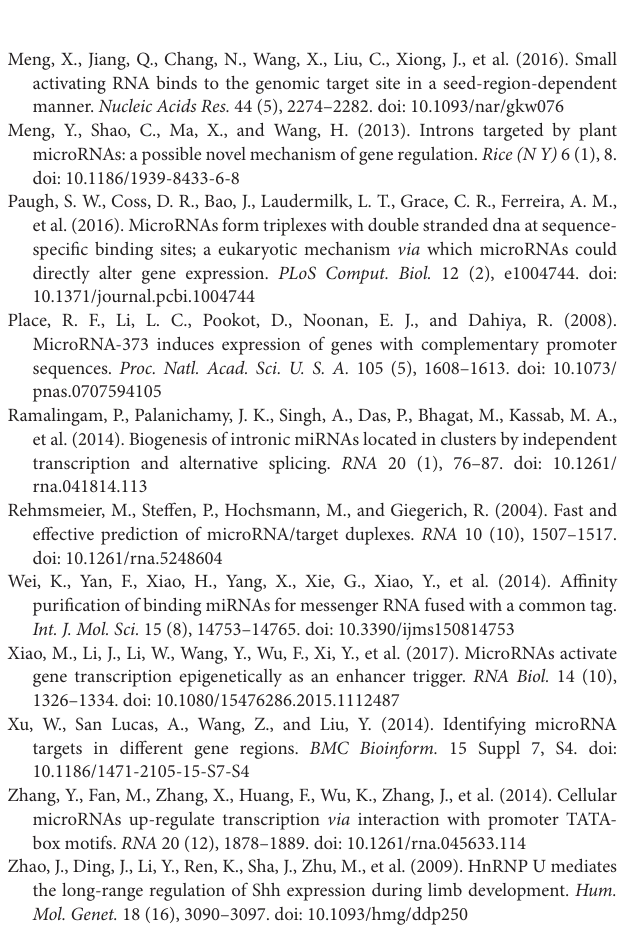
SUPPLEMENTARY TABLE 1 | The peak information of HM-7-DNA. SUPPLEMENTARY TABLE 2 | The peak information of